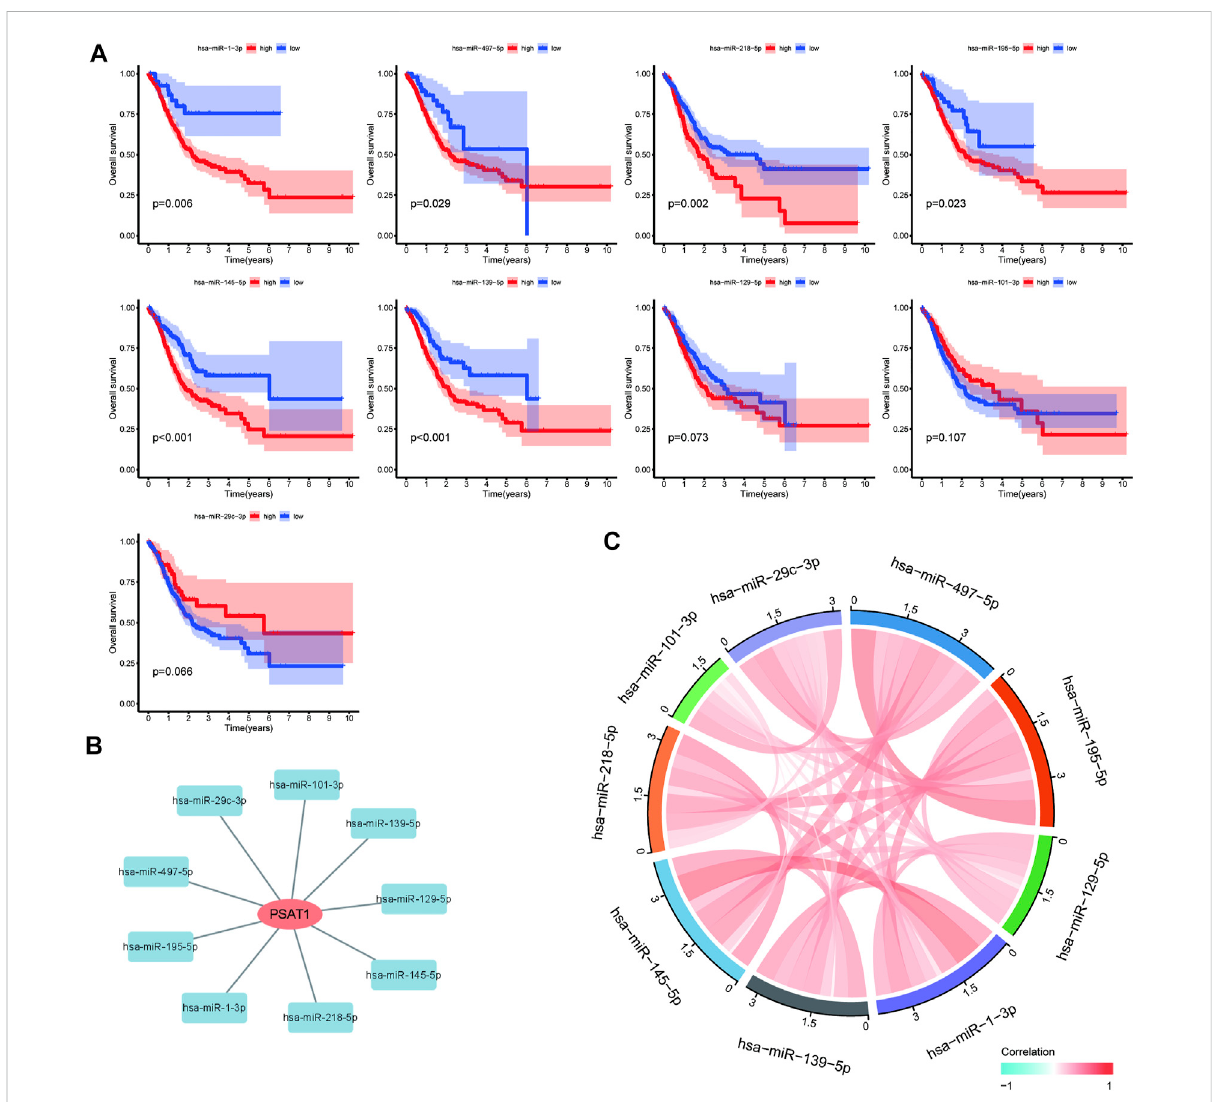
FIGURE 3 Prognostic analysis of microRNAs negatively associated with PSAT1. (A) . Survival analysis of miRNAs (hsa-miR-218-5p, hsa-miR-129-5p, hsa- miR-145-5p, hsa-miR-139-5p, hsa-miR-195-5p, hsa-miR-1-3p, hsa-miR-29c-3p, and hsa-miR-497-5p) signi fi cantly associated with tumor prognosis; (B) . PSAT1-related microRNA regulatory network; (C) . Correlation analysis circle diagram between PSAT1 and its negatively associated